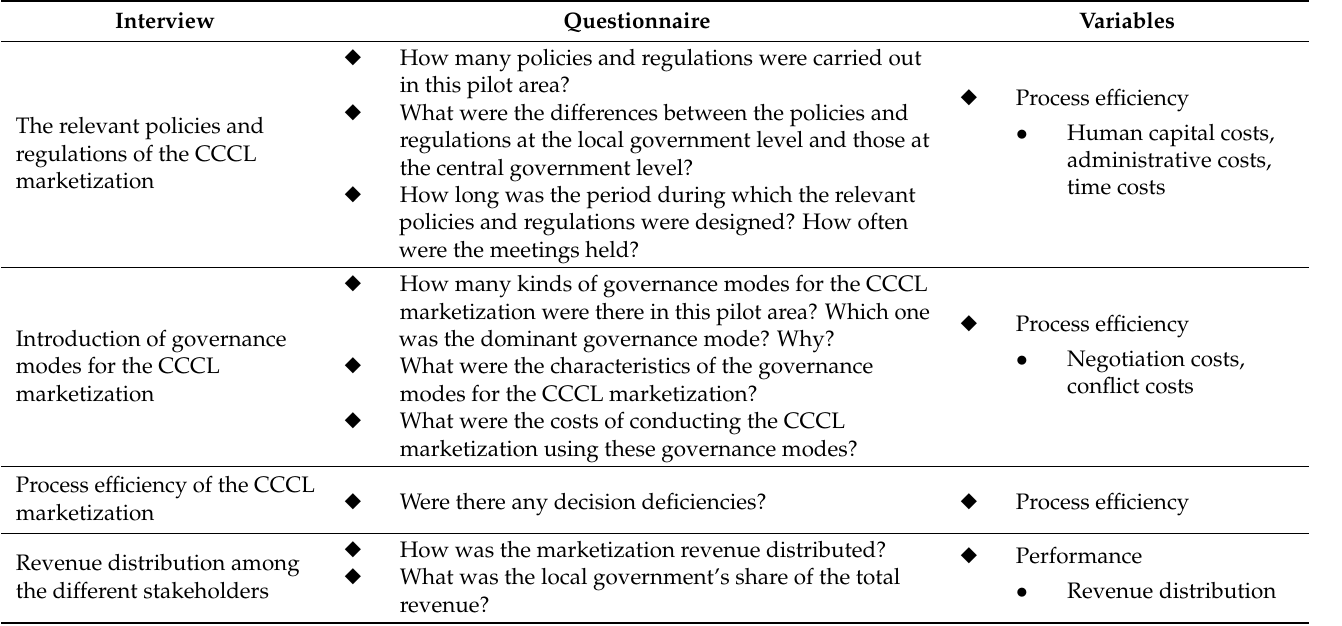
Table 2. The interview, questionnaire, and variables for government officials.